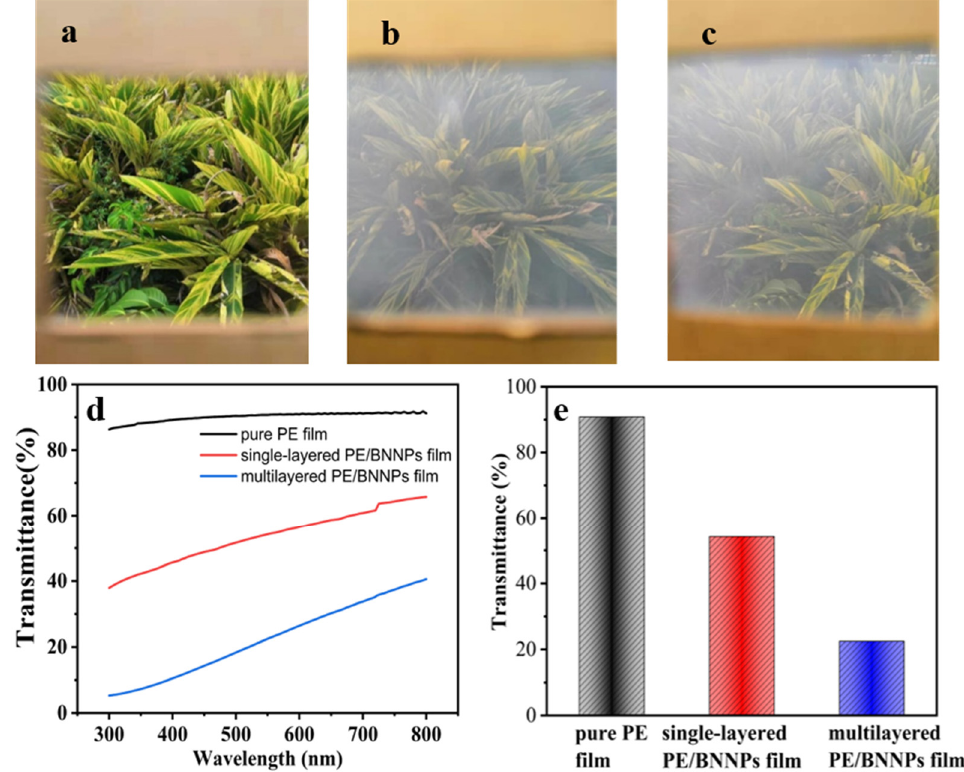
Figure 4. The light transmission performance of single-layered PE/BNNPs films and multilayered PE/BNNPs film. ( a – c ) Optical picture of pure PE film, single-layered PE/BNNPs film, and multi- layered PE/BNNPs film, respectively. ( d ) The transmittance-wavelength curves of different films. ( e ) The transmittance comparison of different films at the wavelength of 550 nm.